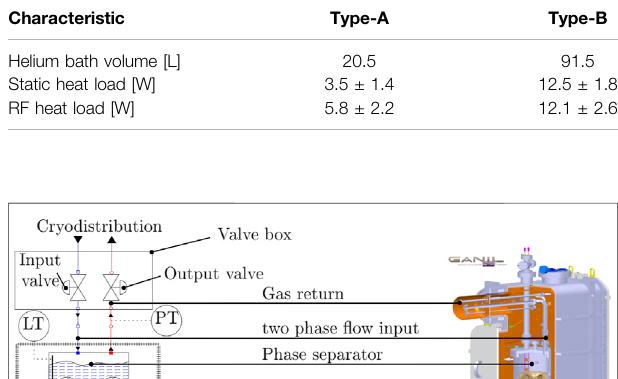
TABLE 1 | Main thermal differences between type-A and type-B cryomodules.